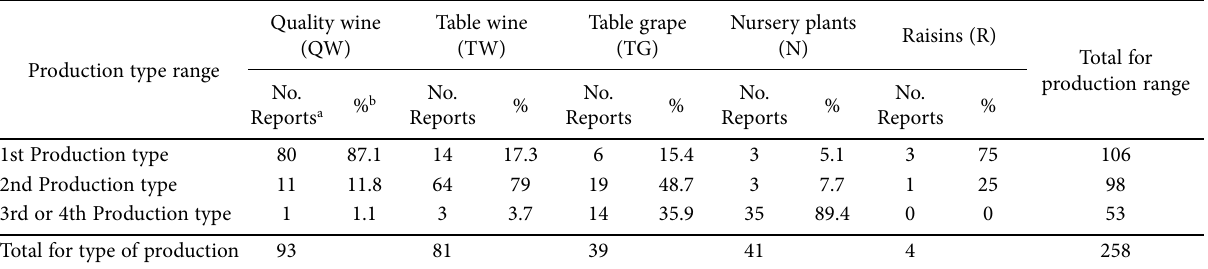
Table 2. Estimates of the relevance of grapevine production types, based on frequency of reports from the all viticultural regions surveyed. Table wine Table grape Nursery